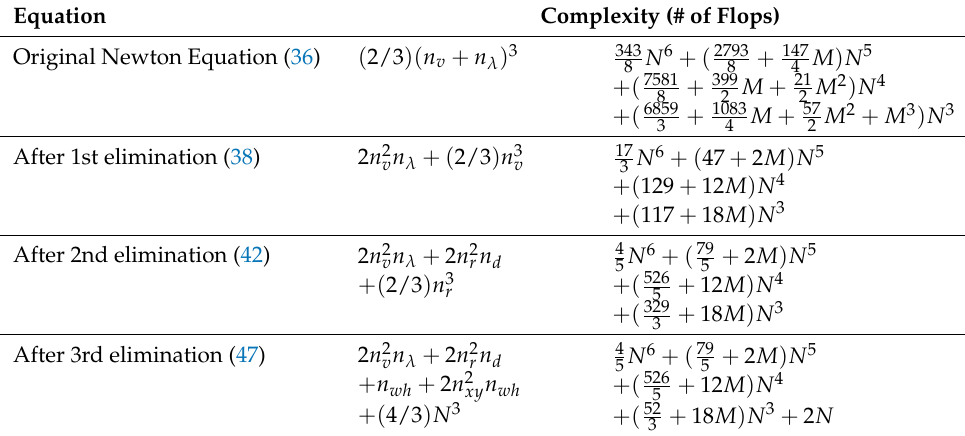
Table 1. Summary of complexity to solve Newton